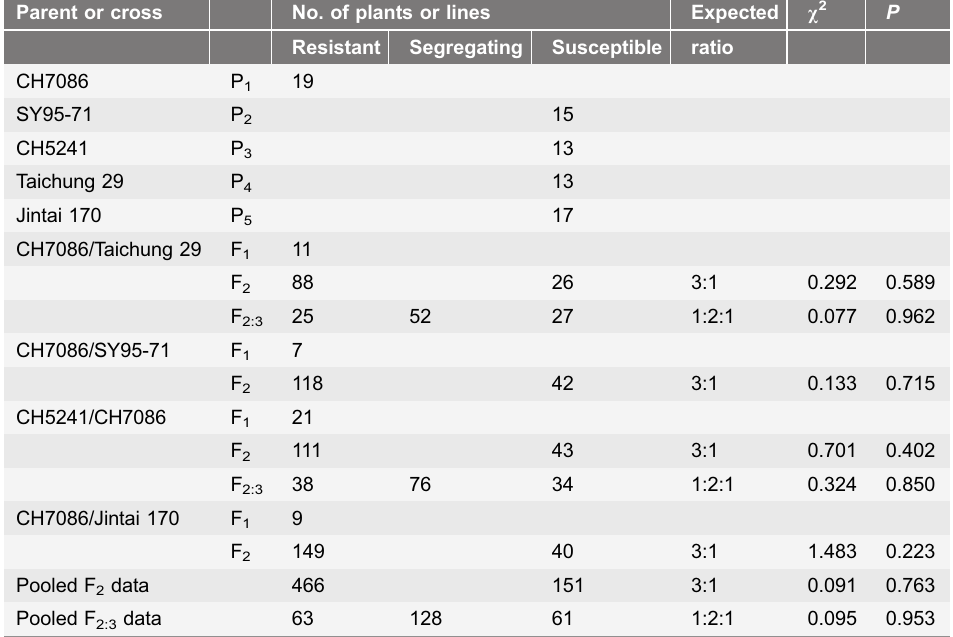
CH7086/Jintai 170 F 1 9 F 2 0.223 Pooled F 2 data 466 151 0.763 Pooled F 2:3 data 63 128 Values for significance of x 2 at P 5 0.05, and 3.83 for 1 df and 5.99 for 2 df ,